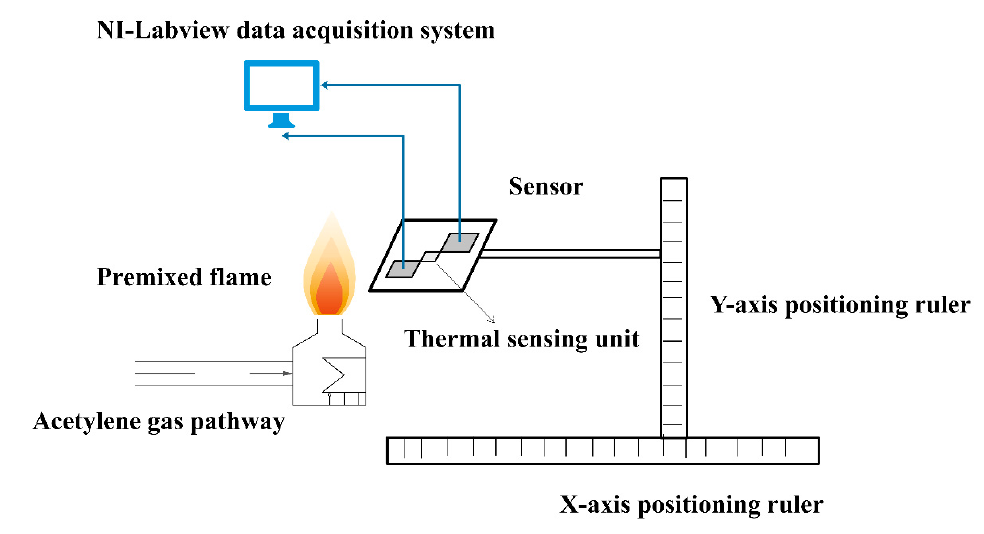
Figure 14. Schematic diagram of acetylene flame testing platform.